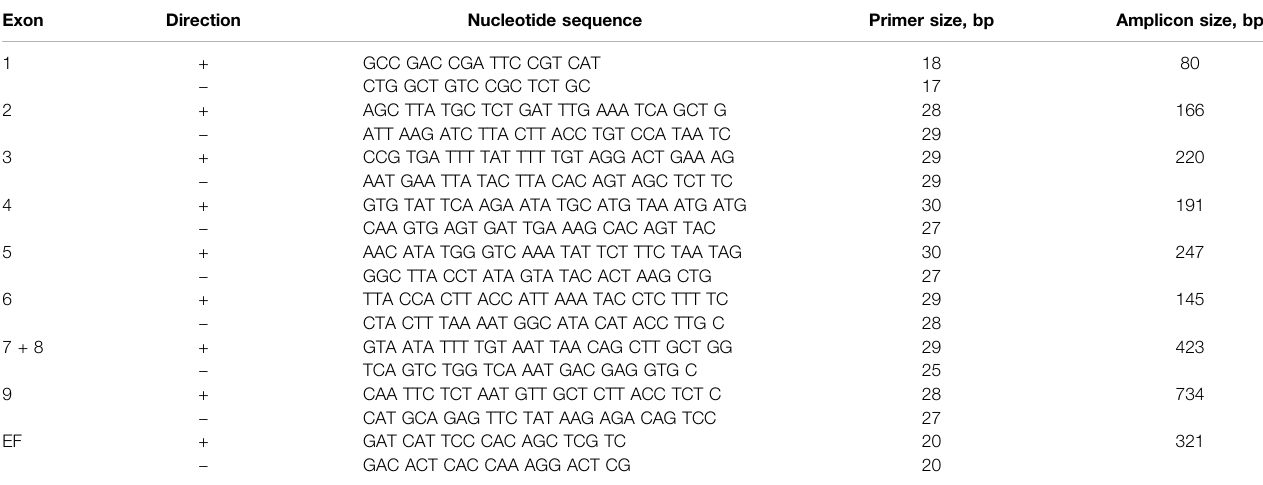
TABLE 2 | Oligonucleotide primers for the HPRT gene exons used in this study. Exon